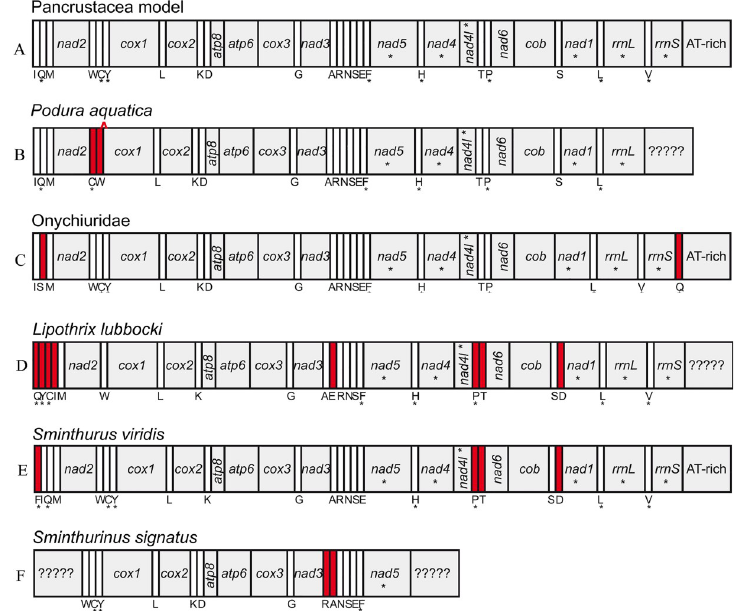
Fig 1. Comparison of linear arrangements of genes on mitochondrial genomes of collembolan species in this study. A. Pancrustacea (putative ancestral) model in most species. B. Podura aquatica . C. Onychiuridae. D. Lipothrix lubbocki . E. Sminthurus viridis . F. Sminthurinus signatus . The transcriptional direction of mitochondrial genes is from left to right, the asterisk ( � ) below the genes indicates the opposite direction, the question marks indicates the unknown genes, the rearrangements are marked in red, the inverted triangle indicates the deletion of